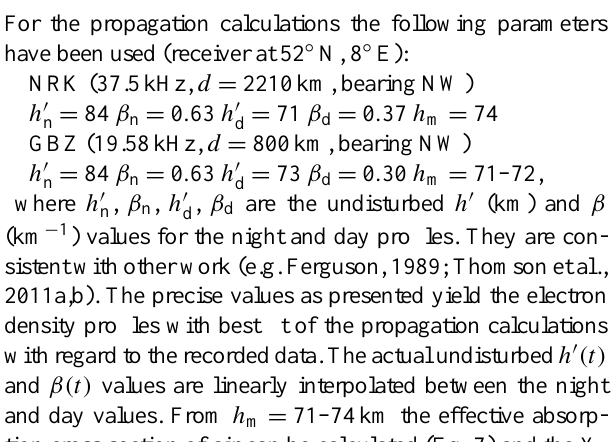
Fig. 6. On 12 July 2012 with X1.4 flare from sunspot group AR 1520 directly facing earth and peaking at 16:53UT; left panel: NRK 37.5kHz, = 71km, β = 0 . 37km − 1 , NRK recording starts at 13:30UT; right panel: GBZ 19.58kHz, h m = 71km, h 0 h m = 74km, h 0 d d 0 . 30km − 1 . In the middle panels (amplitude and phase) blue and red are the recorded and calculated values, respectively. In the upper panels (here and in the following figures) the green function displays the cosine of suns zenith angle shifted to 94 degrees as start value with regard to an illumination height of about 70km above